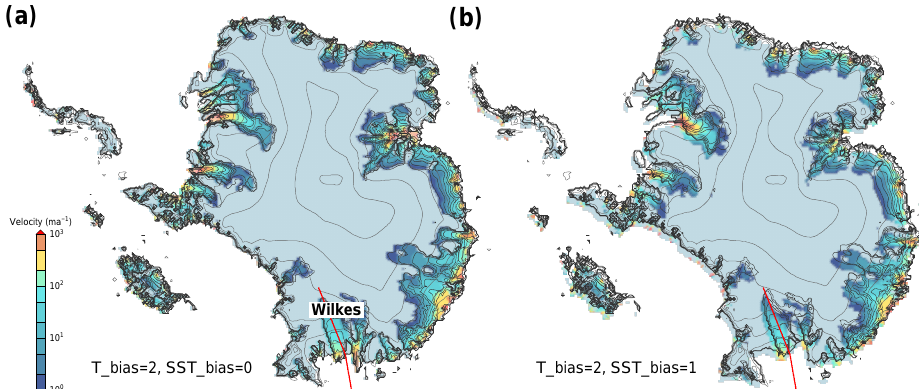
Figure 6. Basal ice velocities for the simulated early Pliocene ice sheet under environmental conditions from regional climate model sim- ulations using two different bias adjustments. Fastest-flowing outlets occur in the subglacial basins and troughs of East Antarctica. These zones correspond to inferred areas of subglacial erosion during past warm climates (Cook et al., 2013; Aitken et al., 2016). Red line identifies catchment transect shown in Fig. 7.